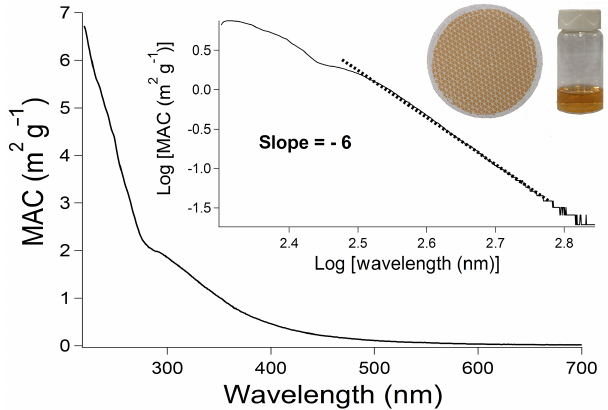
Figure 4. Wavelength-dependent mass absorption coefficient (MAC) of indole SOA. The inset shows the log–log version of the same data used to determine the absorption Angstrom exponent (fit- ted from 300 to 600nm) and photographs of the indole SOA col- lected on a filter and extracted in